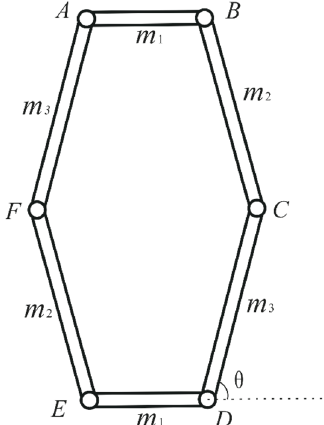
Figure 6. The parameters of the robot trunk.